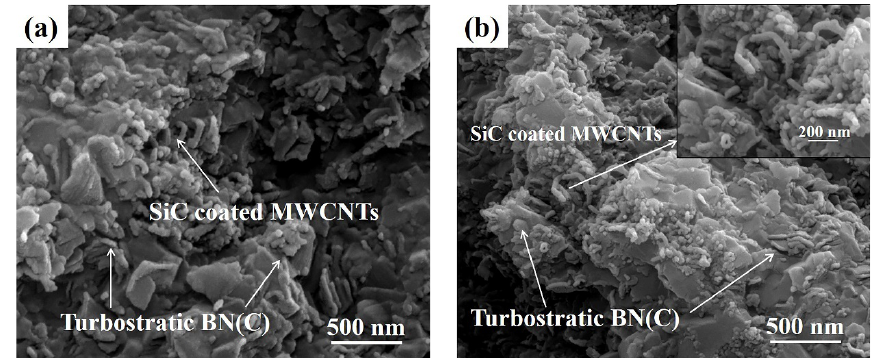
Fig. 5 Micrographs of Si 2 BC 3 N ceramics: (a) SCNT1; (b)